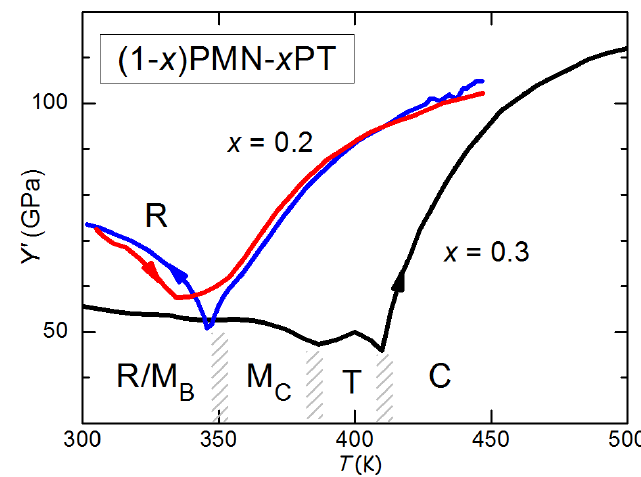
Figure 16. Young’s modulus of two compositions of PMN-PT measured with the DMA at 9 Hz during heating and cooling at 3 K/min (adapted from Ref. [157]). The structural phases are indicated next to the curves